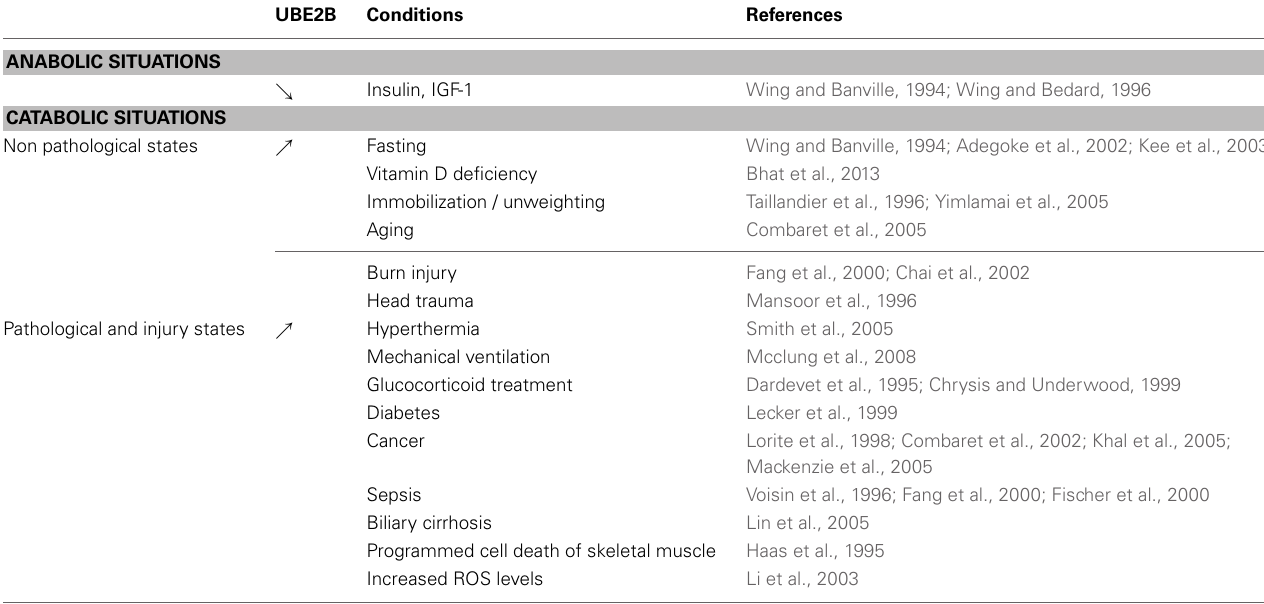
Table 1 | Variation of UBE2B mRNA levels in anabolic and catabolic